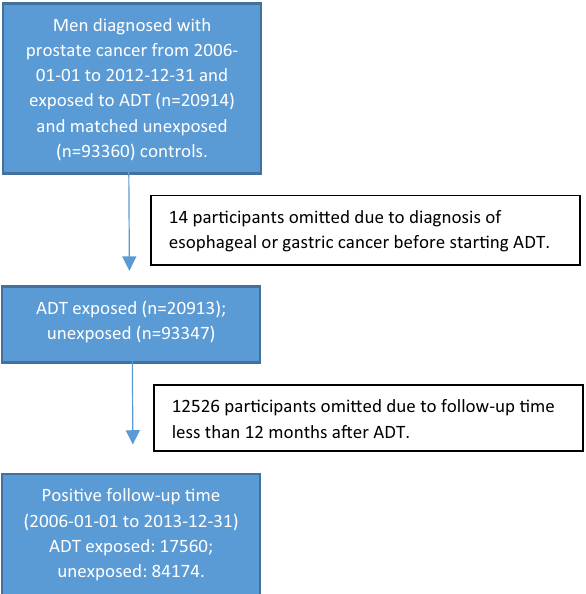
Figure 1. Flowchart of study cohort formation. Prostate cancer patients diagnosed between 2006-01-01 and 2012-12-31 in PCBaSe traject exposed to androgen deprivation therapy (ADT) and their 1:5 matched controls were entered into the cohort. This was a total of 20,914 exposed and 93,360 unexposed participants. Firstly, 14 participants with a diagnosis of esophageal or gastric cancer prior to starting ADT were omitted. Finally, 12,526 participants were omitted due to a follow-up time of less than 12 months. The resulting cohort of eligible individuals for analysis was a total of 101,734 participants with 17,560 ADT exposed, PC cases and 84,174 non- ADT exposed, cancer free